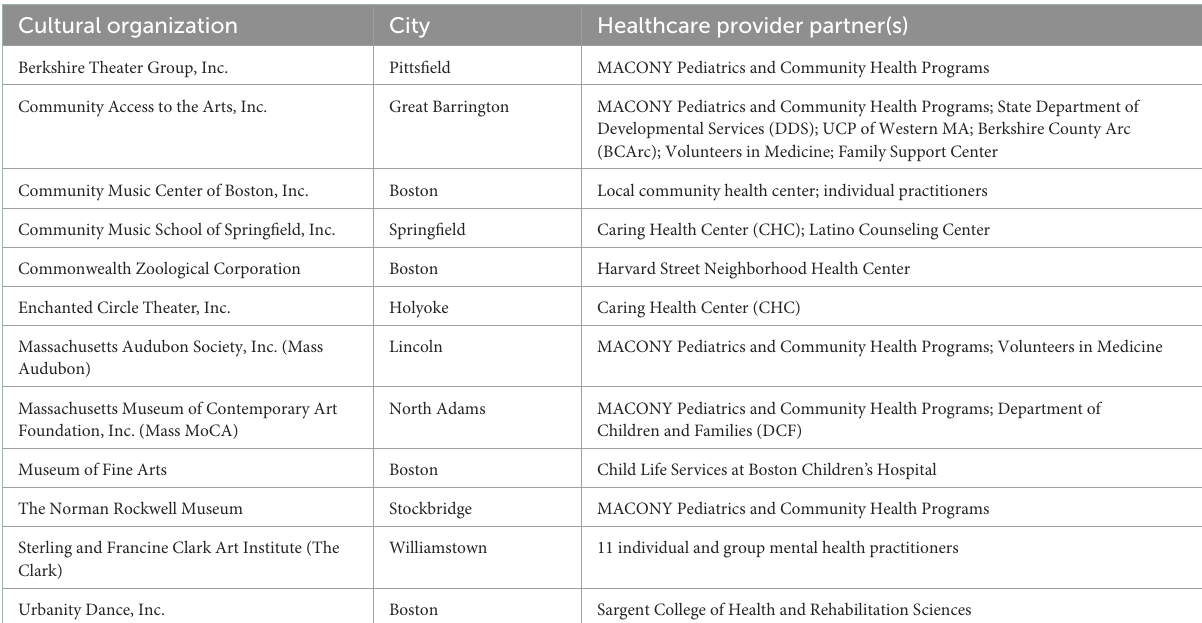
TABLE 2 Cultural organizations and their healthcare